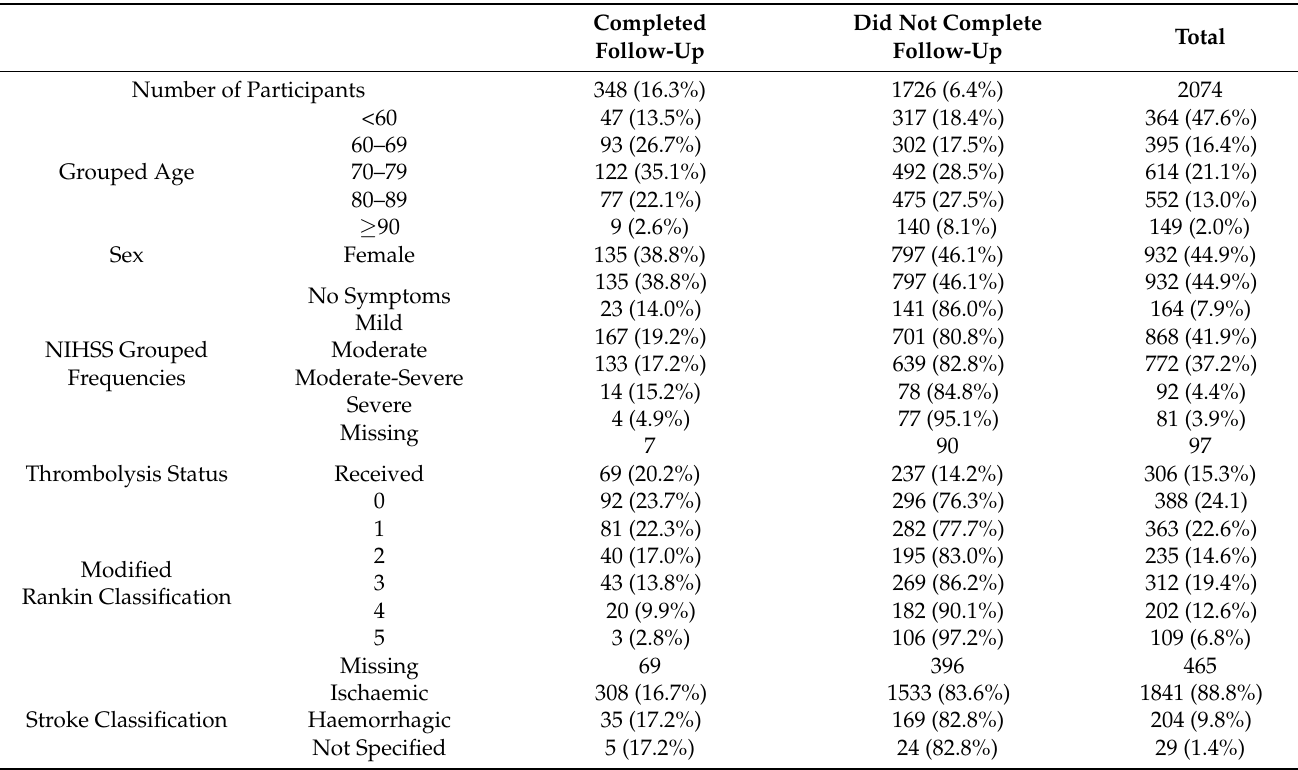
Table A1. Trial Cohort Demographics for Completers, Non-Completers and